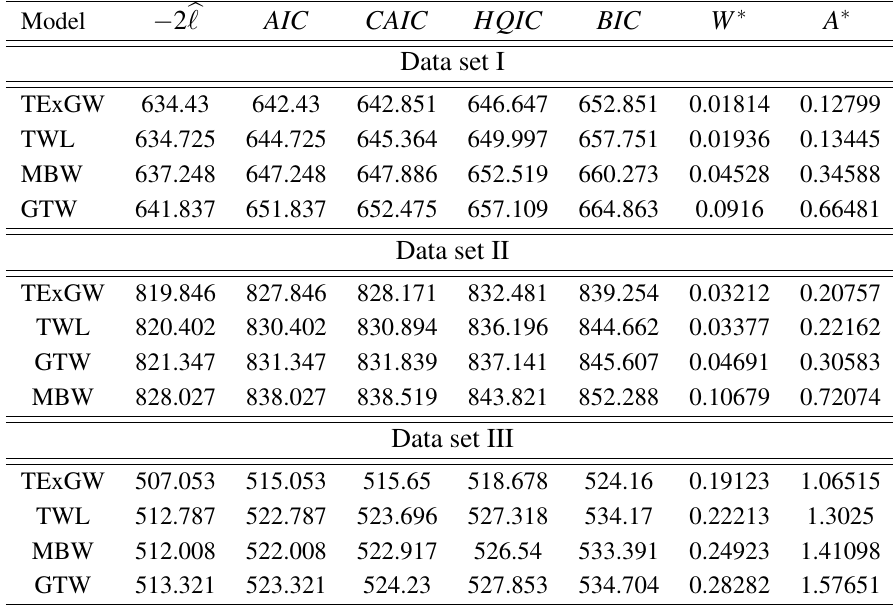
Table 3. Goodness-of-fit statistics for the data sets I, II and III.